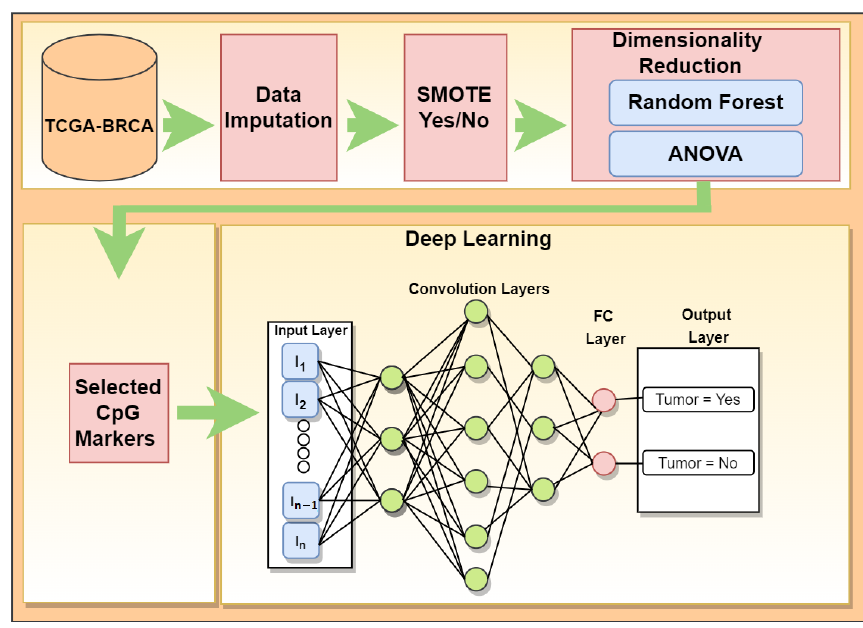
Figure 2. Developed workflow to classify samples as tumor or